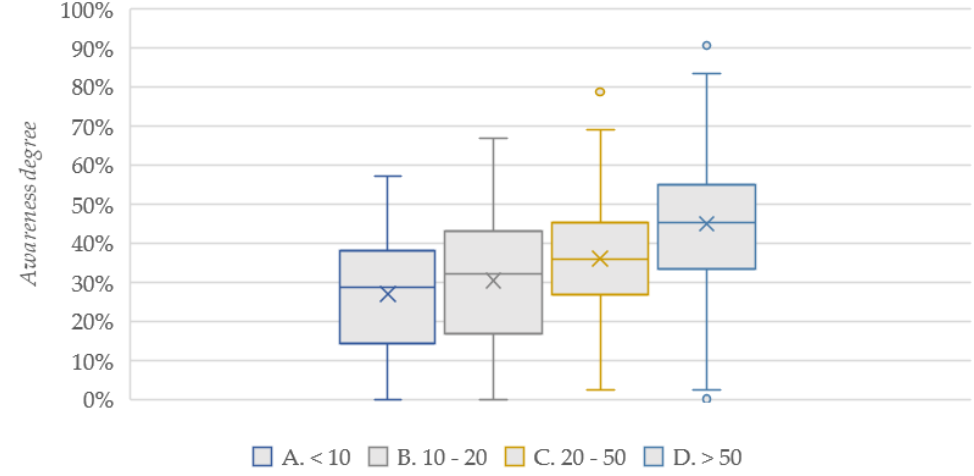
Figure 4. Boxplot graph of awareness level depending on the size of the company (land size).